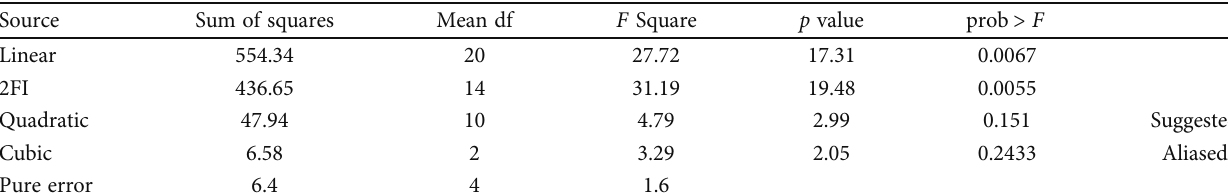
Table 6: Quadratic model for adsorption of Congo red dye on breadfruit leaf biochar adsorbent: lack-of- fi t statistics. Source